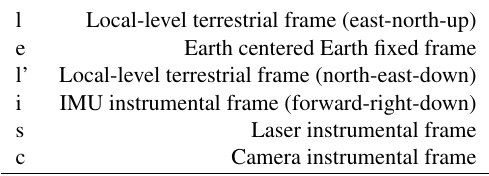
Table 1: Reference frames and coordinate systems.